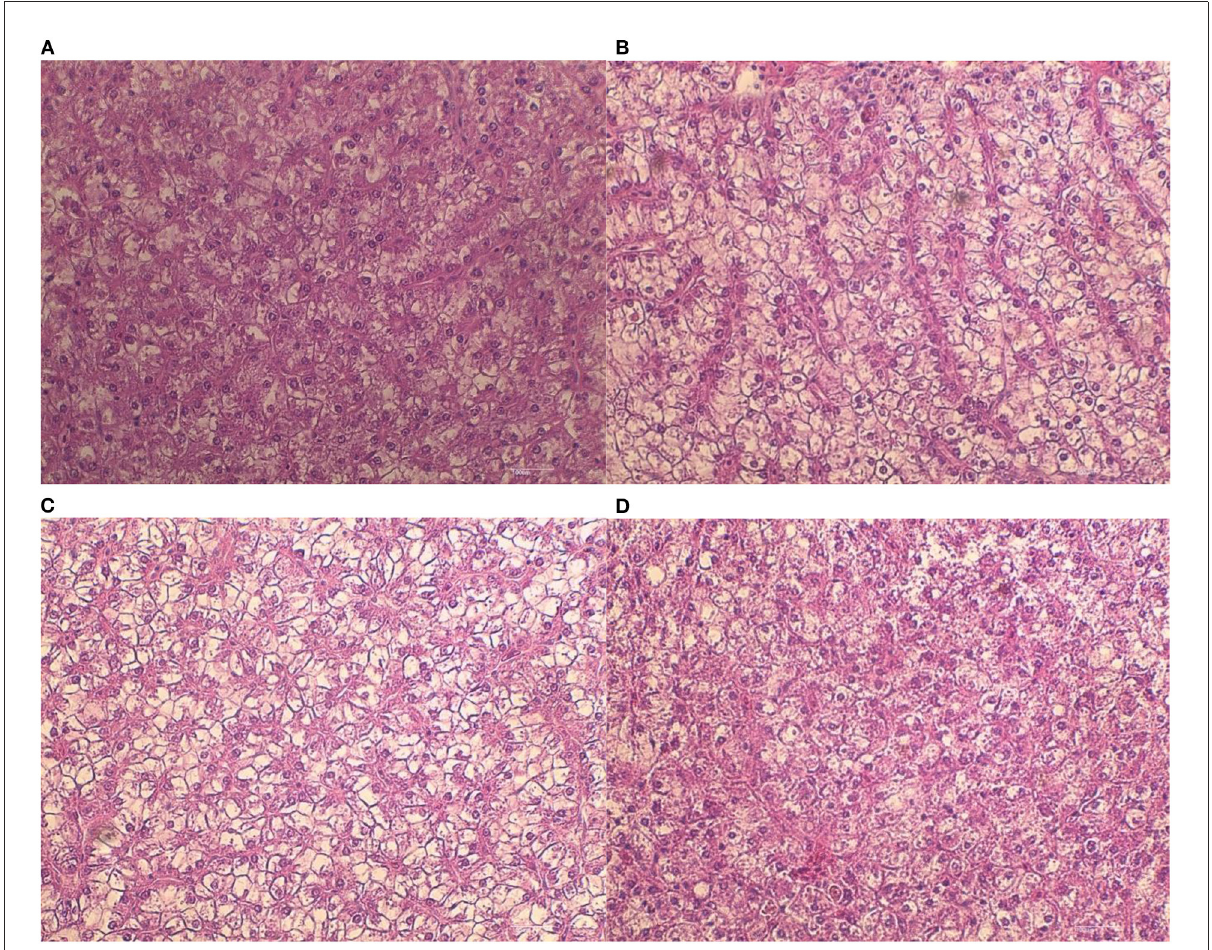
FIGURE4 Liver morphology of seawater-tolerant tilapia fed with different levels of T. weissflogii paste; (A) D0, (B) D1, (C) D2, (D) D3. Scale bar = 100 µ